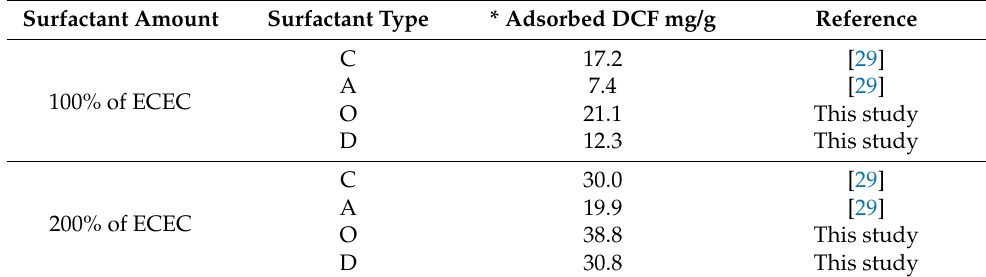
Table 3. DCF adsorption on P composites with different